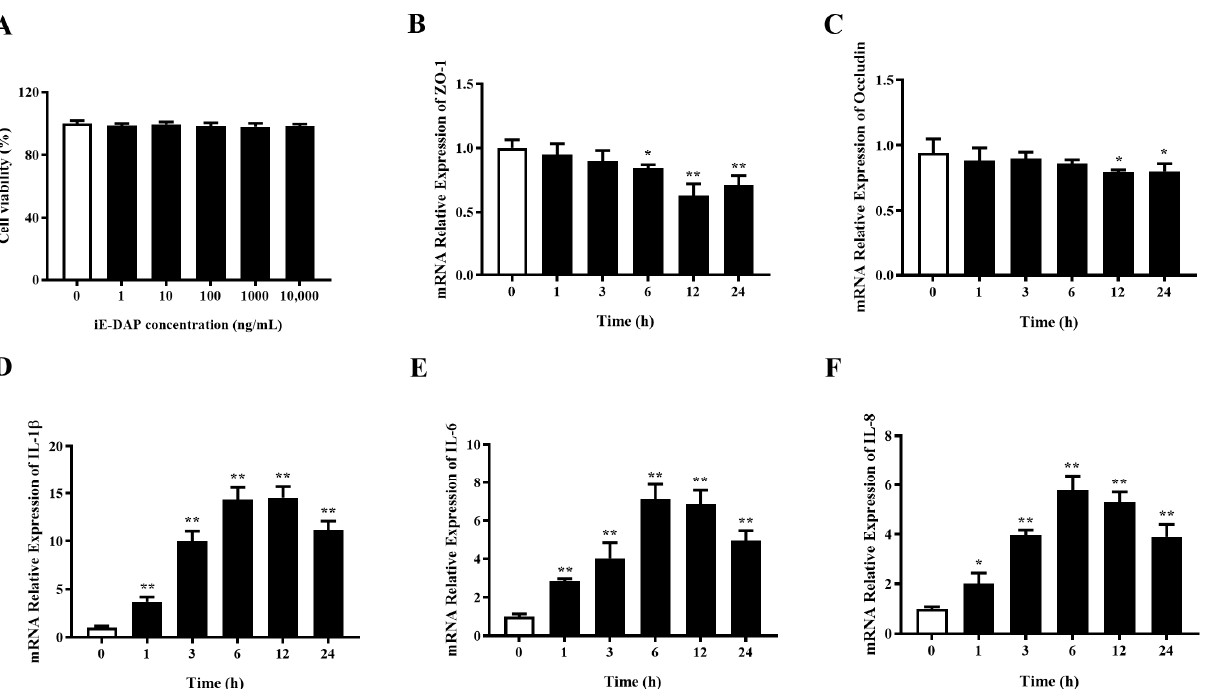
Figure 1. The mRNA expression of inflammatory cytokines and tight junction (TJ) protein genes in bovine mammary epithelial cells (BMECs) after γ -D-glutamyl- meso -diaminopimelic acid (iE-DAP) treatment at different time points. ( A ) Cell viability of BMECs treated with different concentration of iE-DAP. ( B , C ) Gene expression of TJ proteins and ( D – F ) inflammatory cytokines in BMECs treated with 1000 ng/mL iE-DAP at different time points (0, 1, 3, 6, 12 and 24 h). Results were expressed as the mean ± SEM. * p < 0.05, ** p < 0.01, representing significant difference compared with the control group.